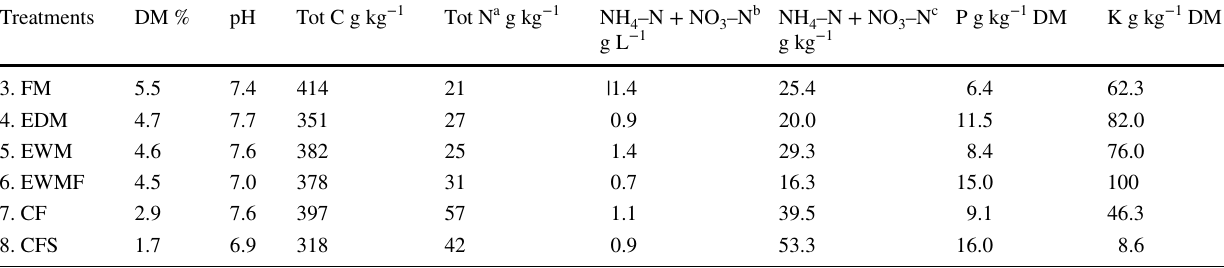
Measured in fresh samples